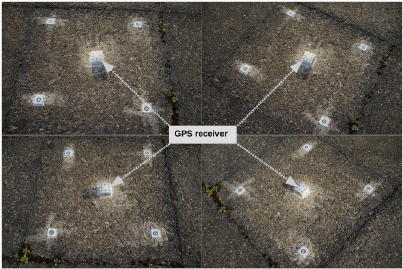
Figure 5: Images of a photogrammetric acquisition of GPS re- ceiver